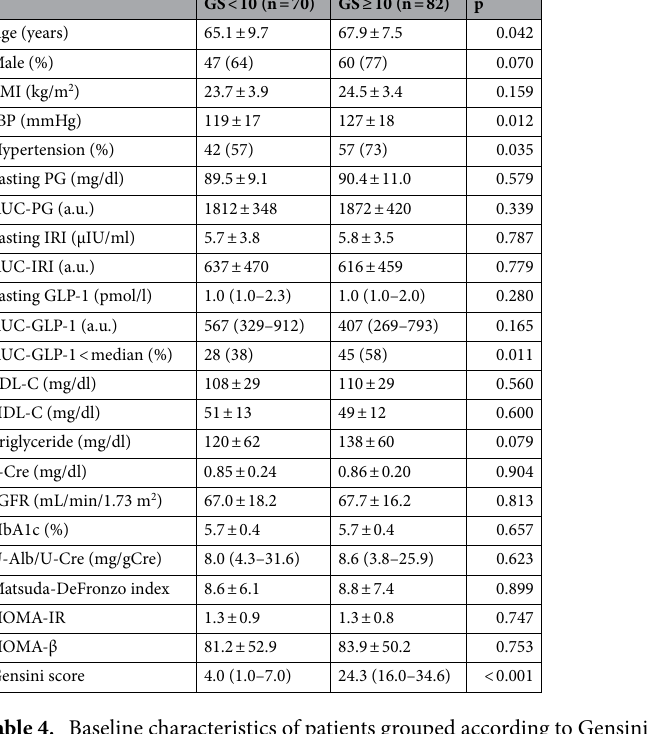
Table 4. Baseline characteristics of patients grouped according to Gensini score being < 10 or ≥ 10. GS: Gensini score; sBP: systolic blood pressure; BMI: body mass index; PG: plasma glucose; IRI: immunoreactive insulin; LDL-C: LDL cholesterol; HDL-C: HDL cholesterol; S-Cre: serum creatinine; eGFR: estimated glomerular filtration rate; HbA1c: hemoglobin A1c; U-Alb/U-Cre: ratio of urinary albumin to urinary creatinine. Data are means ± SD or medians (interquartile